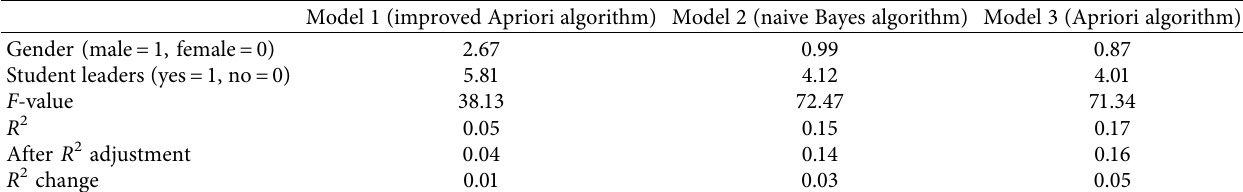
Table 1: Regression analysis of physical exercise behavior evaluation management and school adaptability.